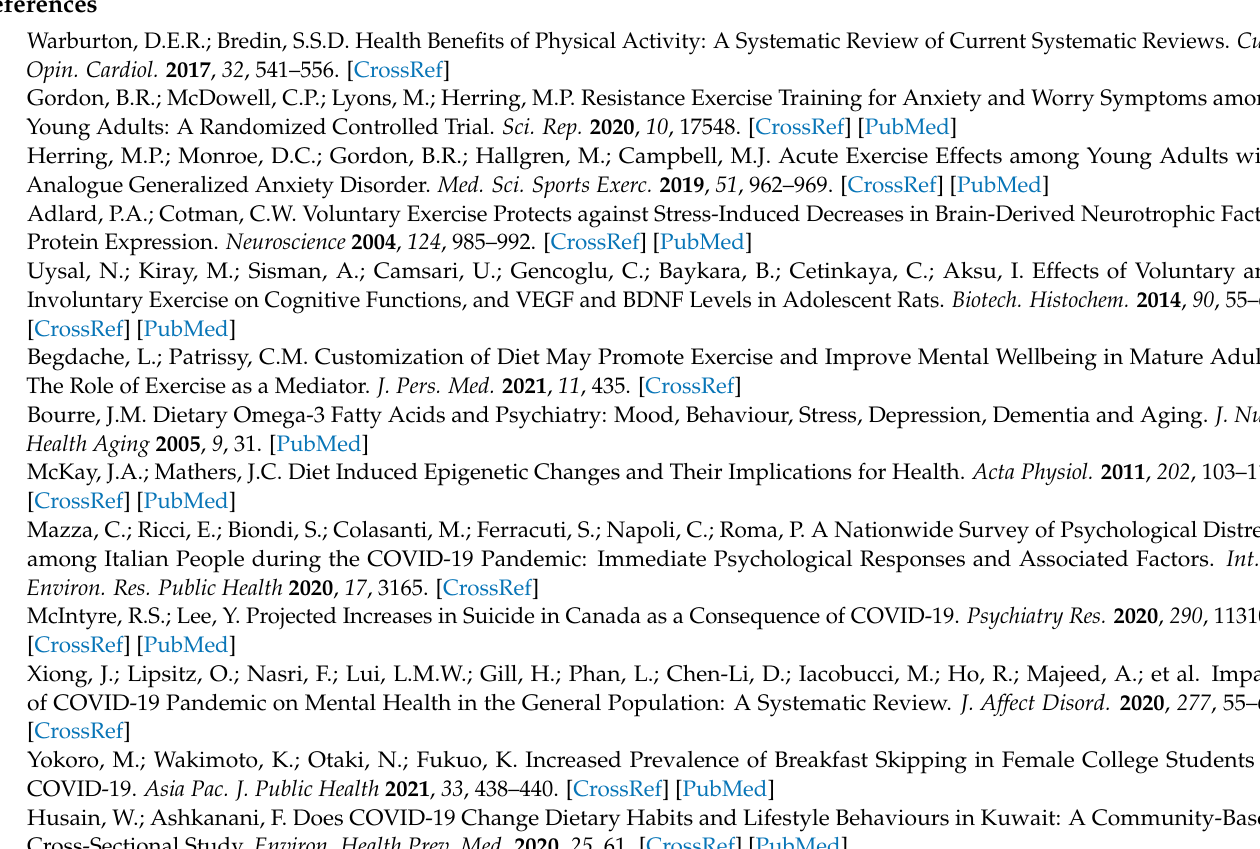
and COVID-19 duration in women. Figure S2: Left: Predicted margins (probability) of each mental distress level by exercise frequency and COVID-19 duration during weekdays, Right: Predicted margins (probability) of each mental distress level by exercise frequency and COVID-19 duration during weekends. Figure S3: Left: Predicted margins (probability) of each mental distress level by exercise frequency and COVID-19 duration in men during weekdays, Right: Predicted margins (probability) of each mental distress level by exercise frequency and COVID-19 duration in men during weekends. Figure S4: Left: Predicted margins (probability) of each mental distress level by exercise frequency and COVID-19 duration in women during weekdays, Right: Predicted margins (probability) of each mental distress level by exercise frequency and COVID-19 duration in women during weekends. Supplementary Materials contains details the numerical tables of margin analyses with the corresponding figures. All tables include a brief summary of the main